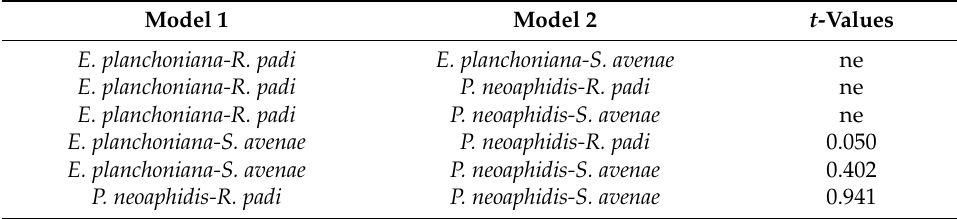
Table 7. Results of t-tests for LT 50 comparisons. Abbreviations: ne = non estimated values due to the absence of LT 50 related to the mortality of R. padi after treatment with E. planchoniana